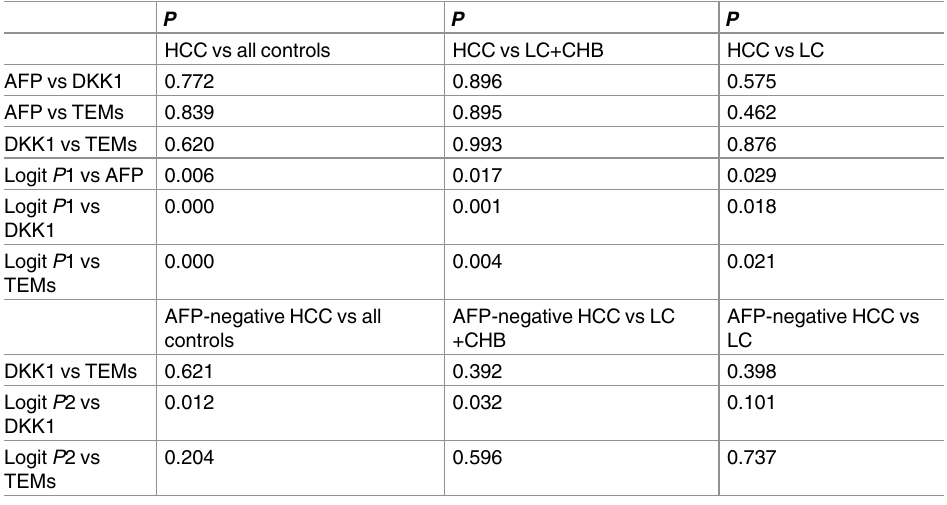
Table 4. Assessment of AUC values of DKK1, TEMs or AFP alone and their combinations in distin- guishing HCC or AFP-negative HCC and other